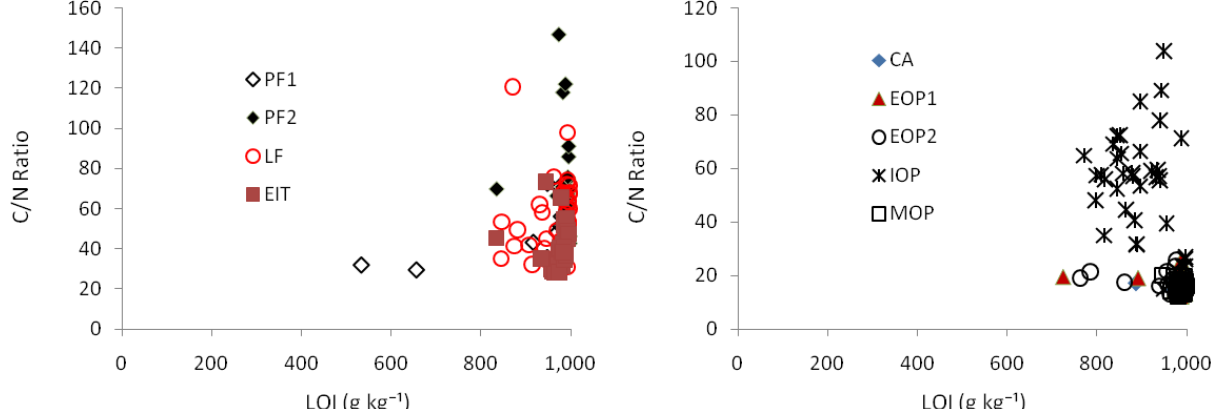
Fig. 5. Scatter plots of LOI versus C/N Ratio according to Land Use Groups (PF1 = coastal peat forest; PF2 = inland peat forest; Figure 5. Scatter plots of LOI versus C/N Ratio according to Land Use Groups LF = logged over peat forest; EIT = industrial timber plantation; CA = community agriculture; EOP1 = Early Oil Palm ( < 5yrs) in coastal peat; EOP2 = Early Oil Palm ( < 5yrs) in inland peat; IOP = Intermiediate Oil Palm (5–10yrs); MOP = Mature Oil Palm (15–20yrs). (PF1= coastal peat forest; PF2= inland peat forest; LF = logged over peat forest; EIT = industrial timber plantation; CA= community agriculture; EOP1= Early Oil Palm (< 5 yrs) in coastal peat; EOP2 = Early Oil Palm (<5 yrs) in inland peat; IOP = Intermiediate Oil Palm (5-10 yrs); MOP = Mature Oil Palm (15-20 yrs)